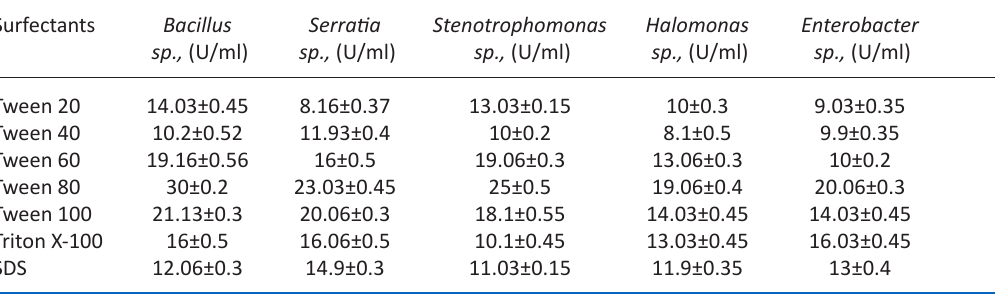
Table 5. Influence of surfactants on lipase